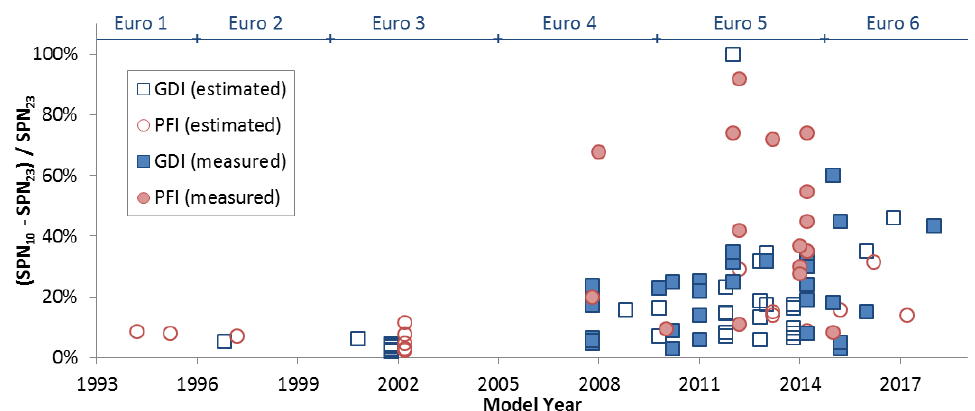
Figure 6. Additional particles below 23 nm. Measured: Based on 23 nm and 10 nm condensation particle counters (CPCs) downstream of a thermal pretreatment unit. Estimated: Based on solid size distributions (Figure 3). No corrections for particle losses in the measurement systems.